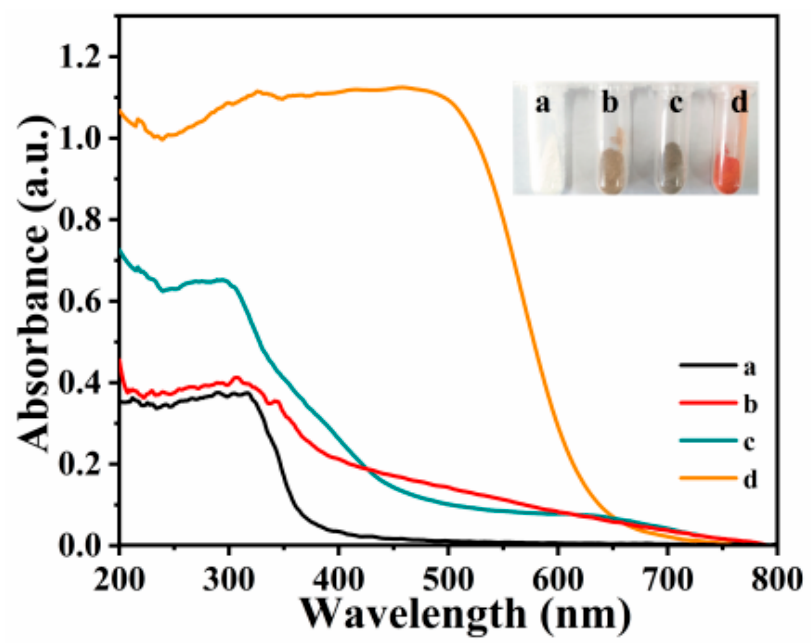
Figure 7. UV-Vis DRS of ( a ) pure BiOCl, ( b ) BOC-SOVs, ( c ) 1% CIS/BOC-SOVs, and ( d ) pure CaIn 2 S 4 . The photocatalytic performance of the prepared photocatalysts is evaluated by de- grading phenol under visible-light irradiation, as shown in Figure 8. Under the exposure of visible light, the concentration of phenol, which possesses a very stable molecular struc- ture, hardly changes, and the adsorption of phenol by the catalyst is almost negligible. According to the results, the calcination temperature and time exhibit a great influence on the photocatalytic activity of BiOCl. A temperature increase from 200 to 400 ◦ C causes an increase in the degradation rate from 50.0% to 23.6%. The degradation rate decreased to 28.9% for BOC-400. Comparing the catalytic performance of catalysts obtained after different calcination times reveals that the catalyst calcined for 1 h demonstrates the highest activity with a degradation rate of 63.4% and a reaction rate constant of 0.0265 min − 1 . The concentration of OVs depends on the calcination temperature and time. However, too many OVs will become the photogenerated electron/hole recombination center and cause electron-hole annihilation, which results in decreasing the photocatlaytic